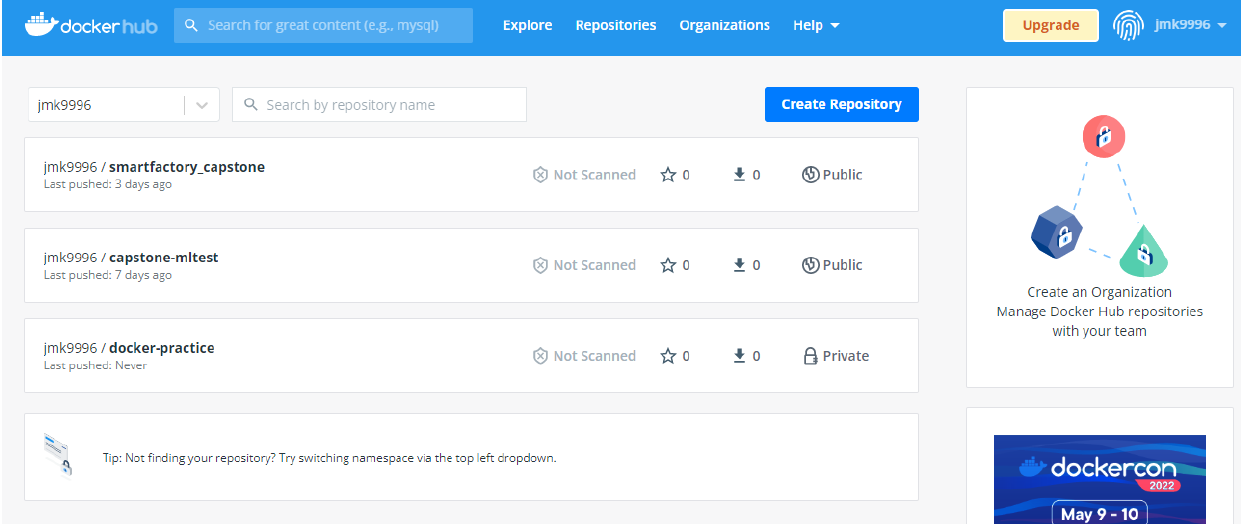
Figure 9. Docker Hub registry for Docker image